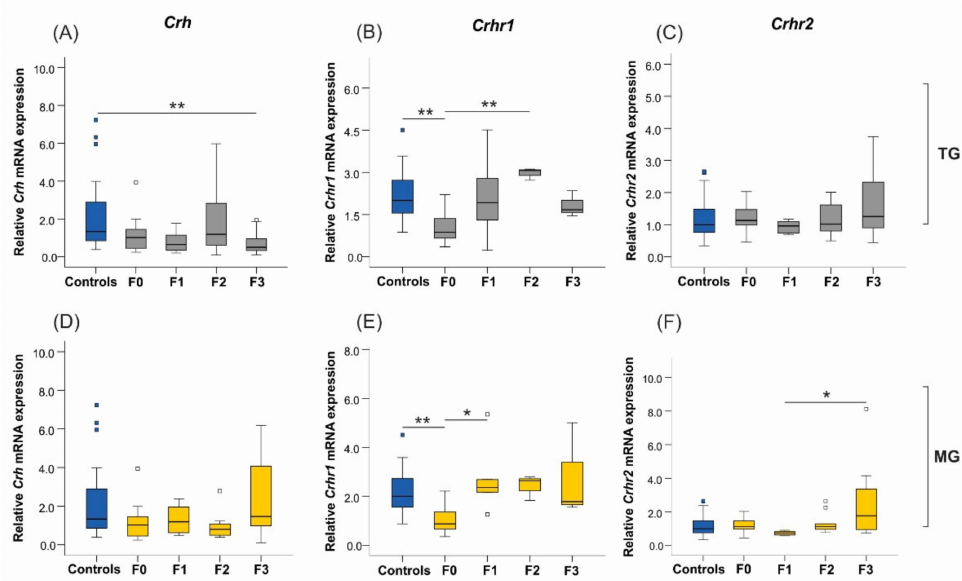
Figure 8. The uterine expression of Crh and Crhr2 reacted differently in TG and MG lineages, while Crhr1 expression patterns were similar. ( A ) The mRNA expression of Crh was significantly reduced in the F3 generation of the TG group, ( D ) yet, no changes were observed in the MG lineage. ( B ) The Crhr1 expression significantly decreased in F0 animals while its abundance tripled in the TG F2 generation. ( E ) The same pattern was observed in the MG lineage, where uterine expression of Crhr1 was significantly downregulated in the F0 generation but doubled in the F1 offspring ( C ). The expression of Crhr2 was unchanged in the TG lineage, while ( F ) it significantly increased in the F3 animals exposed to cumulative MG stress. Asterisks indicate significance. * p < 0.05; ** p < 0.01. Controls n = 20–31; F0 n = 8–10; F1 n = 5–8, F2 + F3 n = 4–12. Box plots mid-lines indicate